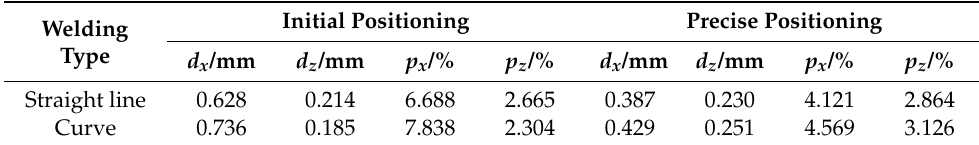
Table 6. Error analysis